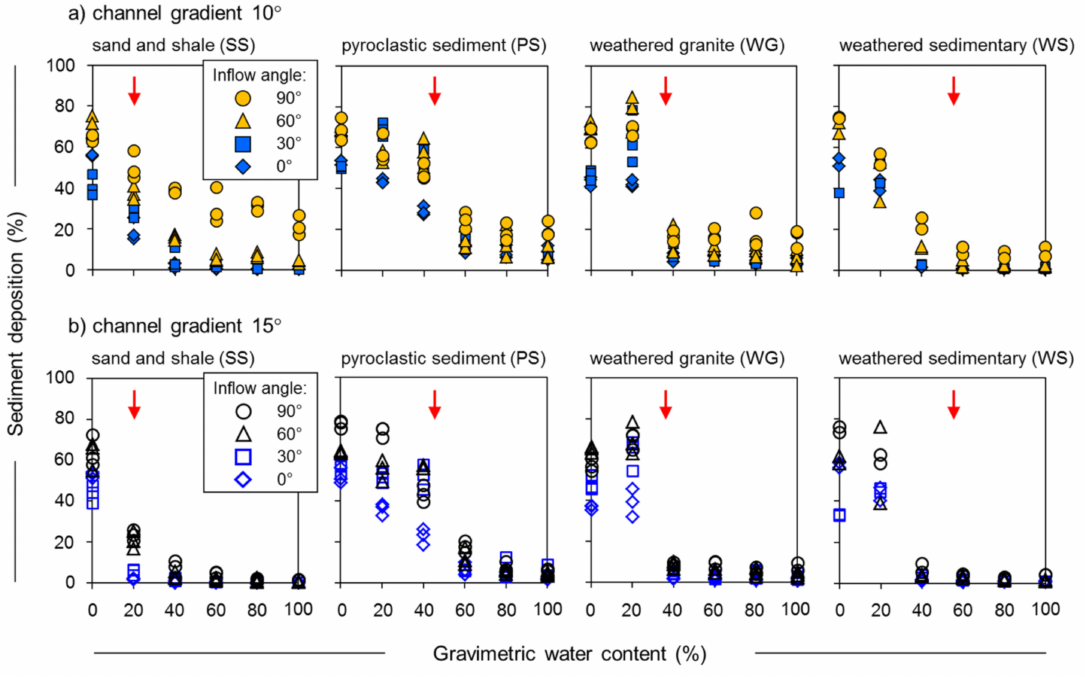
Figure 5. Sediment deposition at the junction (section B ) for four sediment types. The arrows represent the different saturated water contents of sediments. ( a ) sediment deposition for the 10 ◦ channel gradient; ( b ) sediment deposition for the 15 ◦ channel gradient.